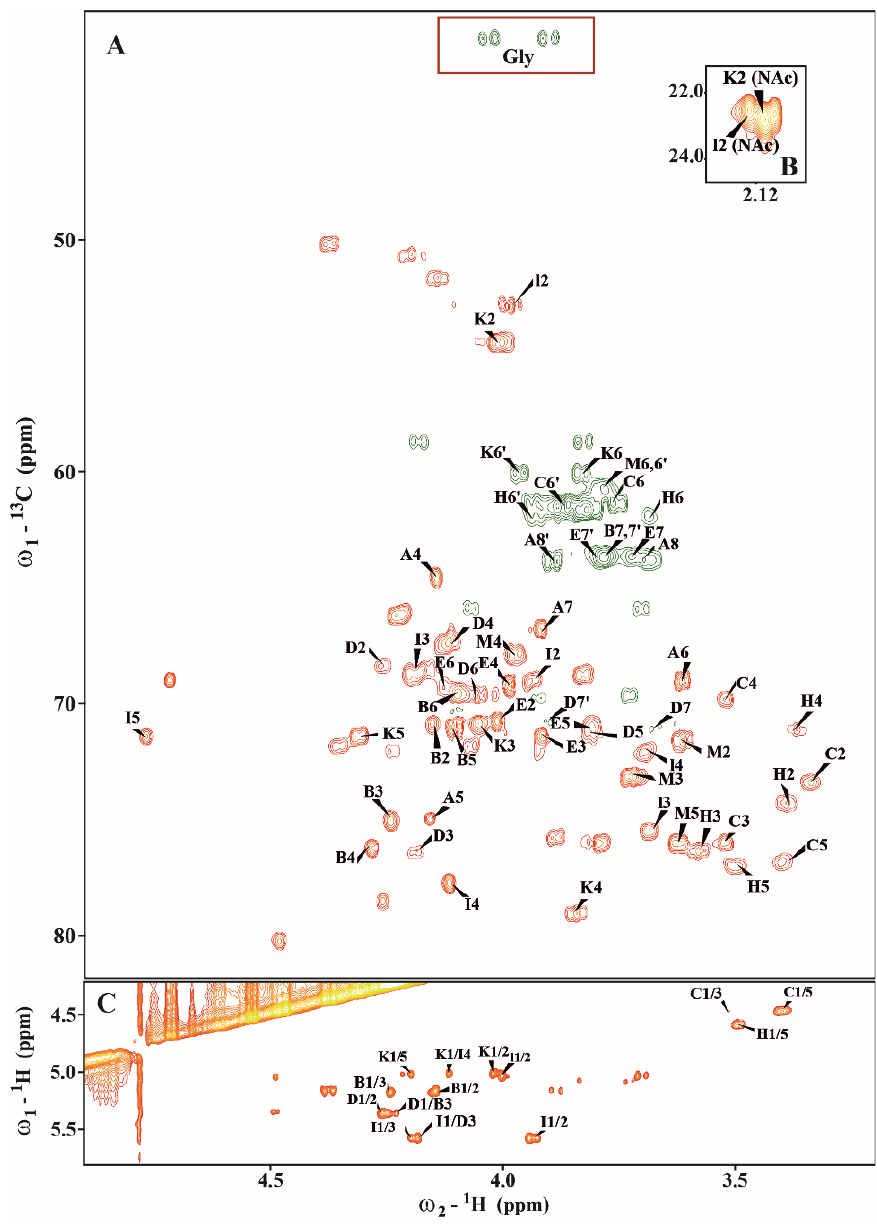
Figure 8. ( A , B ) Selected regions of the 1 H − 13 C HSQC-DEPT and ( C ) 1 H − 1 H NOESY spectra of the fraction OSVII of E. ictaluri AL-15-01-CATFISH core oligosaccharide. Residue A was identified as the 5-substituted Kdo on the basis of characteristic deoxy proton signals at δ H 1.92/2.27 ppm (H-3 ax /H-3 eq ) as well as a high chemical shift of the C −